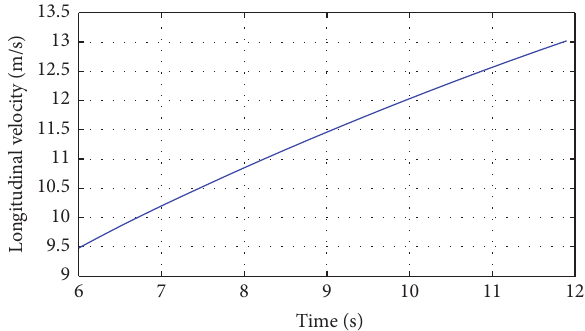
Figure 18: Longitudinal velocity when passing a bump road.